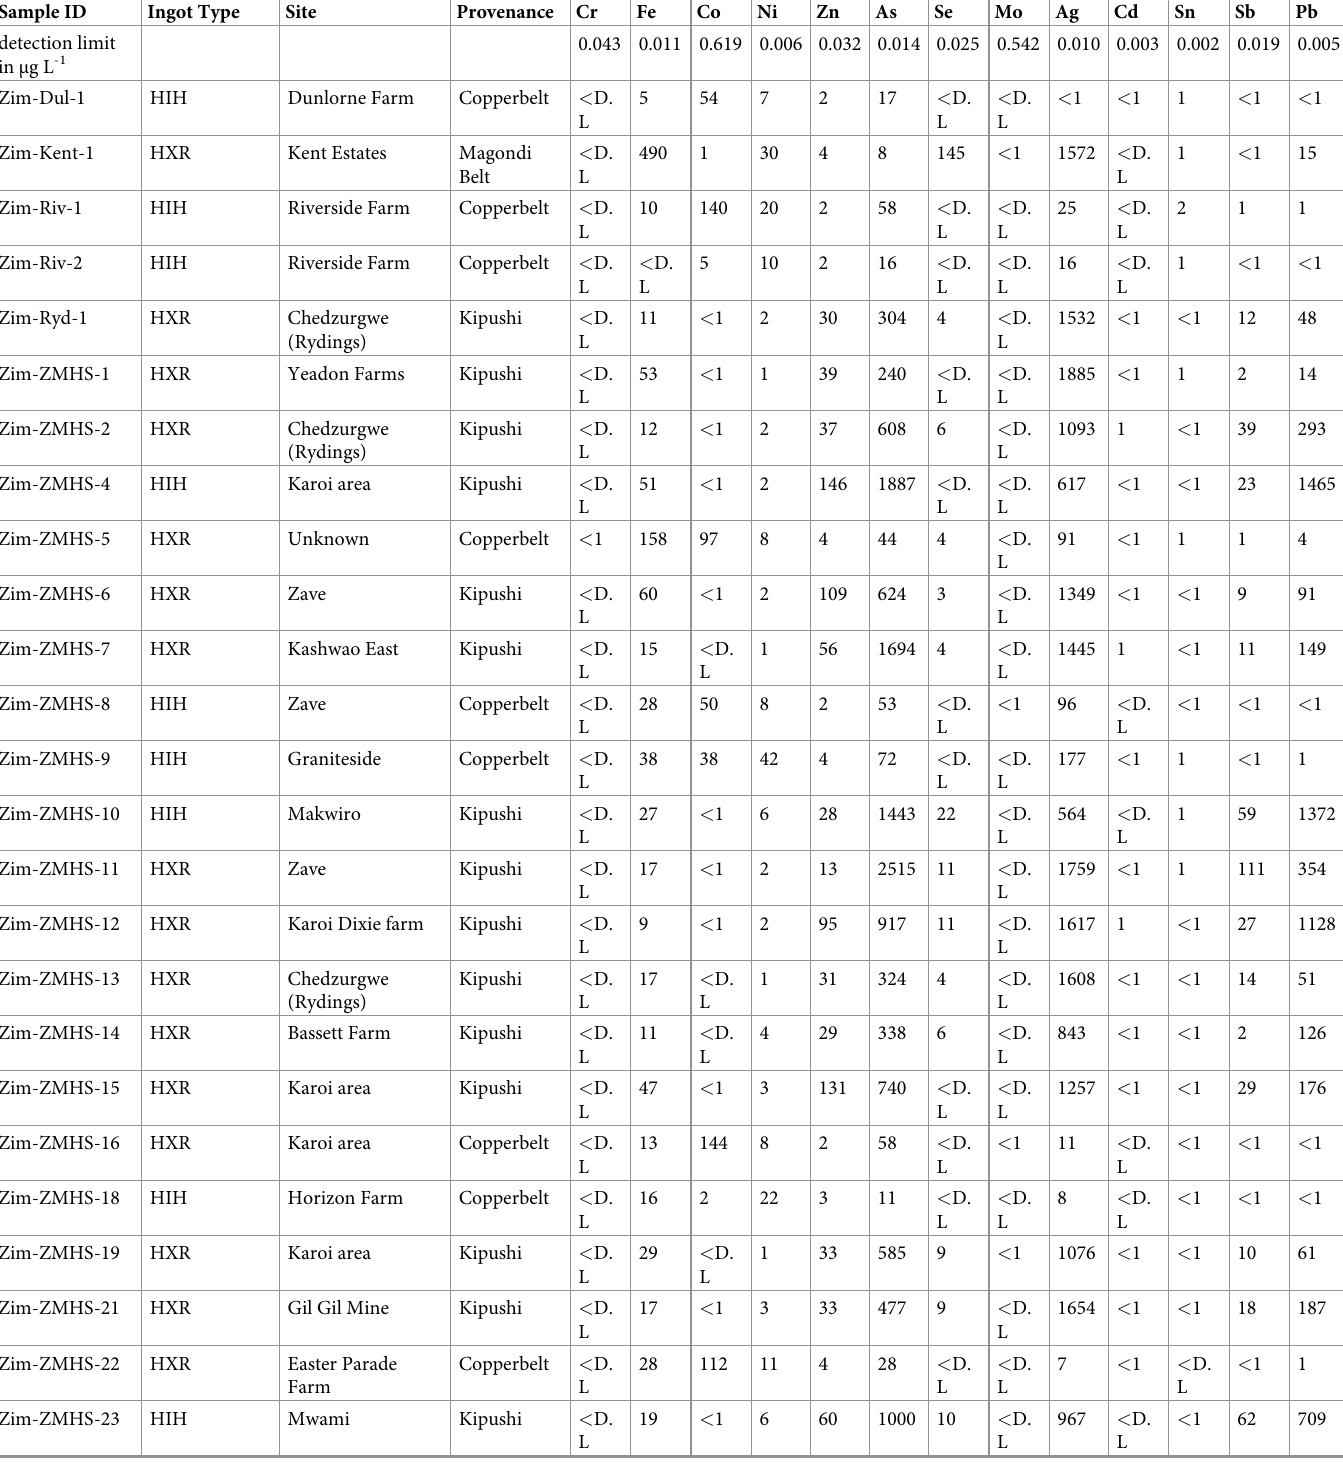
Table 2. Chemical data for samples. All values are reported in μ g g -1 . Detection limits are included in the second row, however these values are reported in μ g L -1 of dis- solved sample in solution. Thus, all values below detection limits were culled prior to converting the sample data to μ g kg -1 (ppb), μ g g -1 (ppm), and wt% in the solid sam- ple. < D.L = less than detection